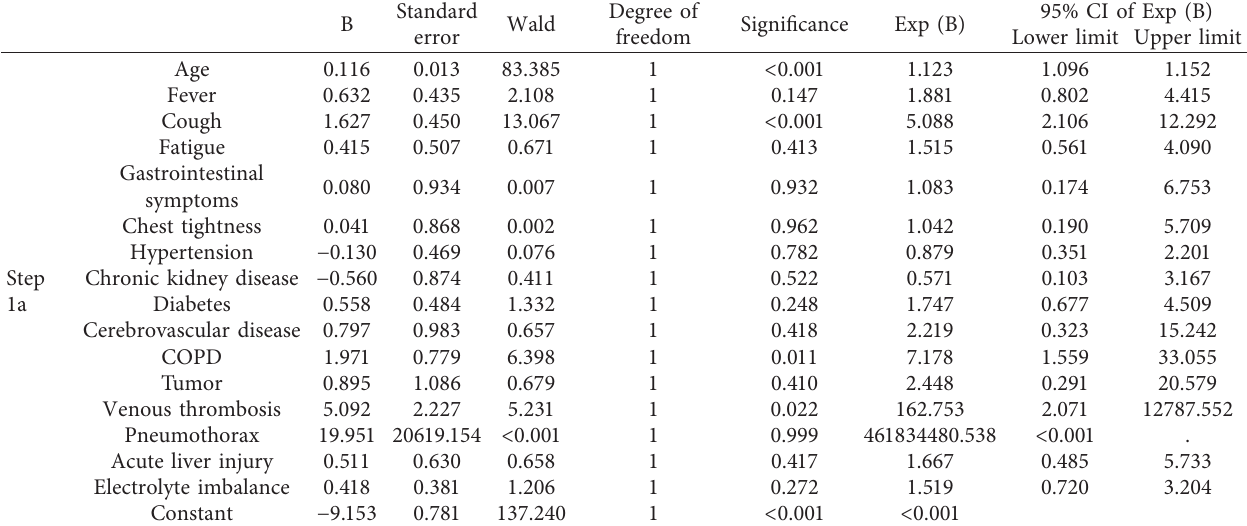
Table 2: Influencing factors for COVID-19 patients developing severe